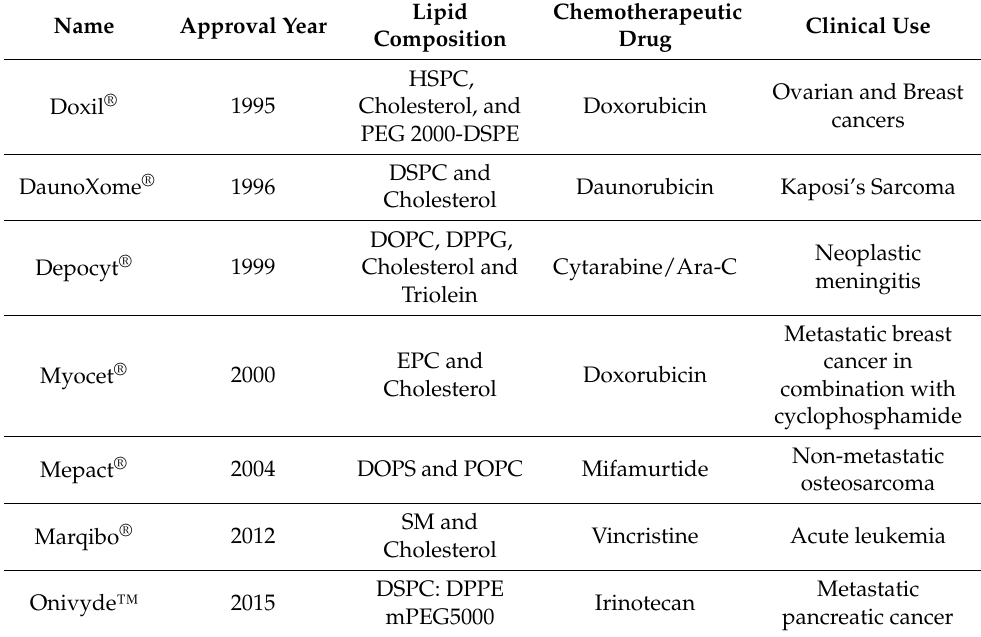
Table 2. FDA-approved liposomal-based formulations in cancer treatment